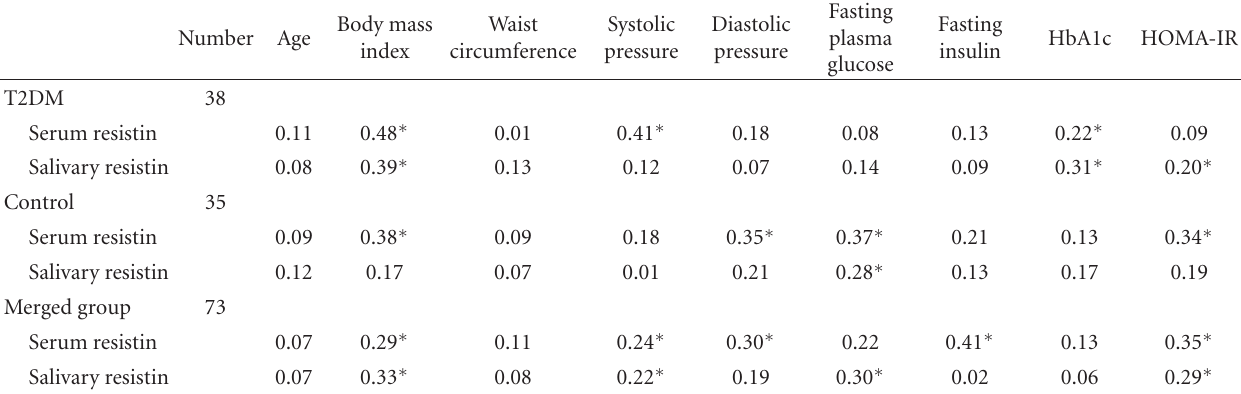
Table 4: Correlation coe ffi cients between serum and salivary resistin levels and anthropometric features